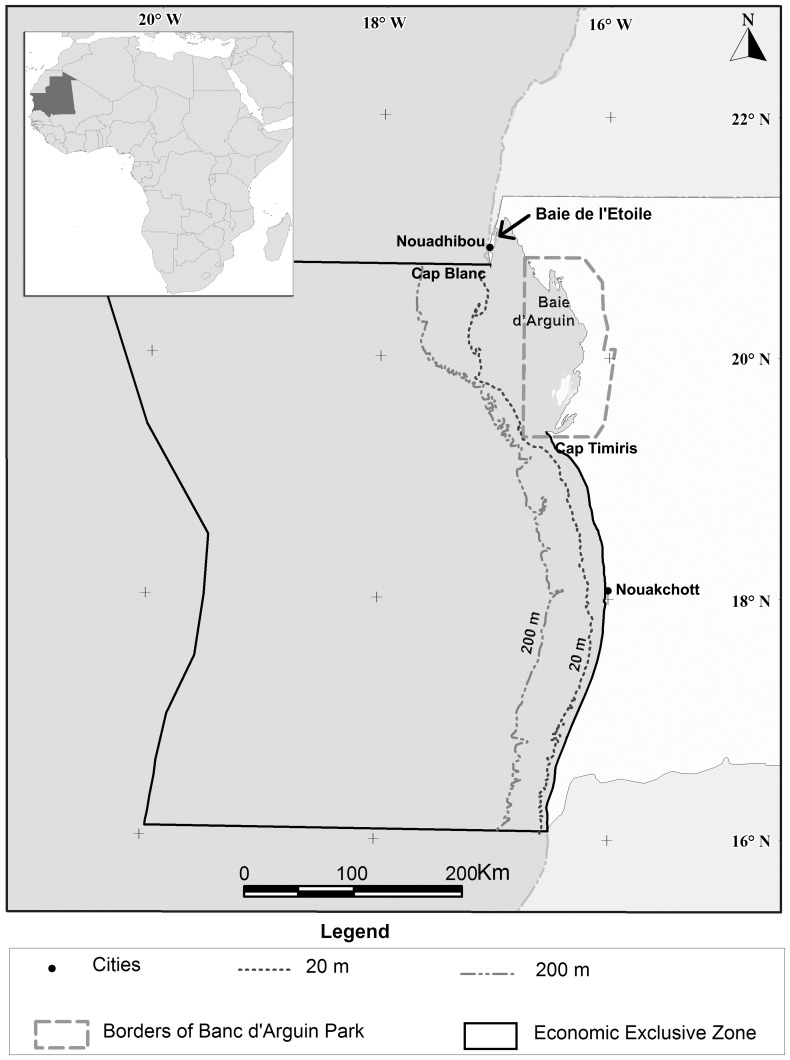
The Mauritanian shelf (the study area) and the Banc d’Arguin National Park (delimited with the black line).The study area covers 33,2242 including the Banc d’Arguin (6,450 km2).